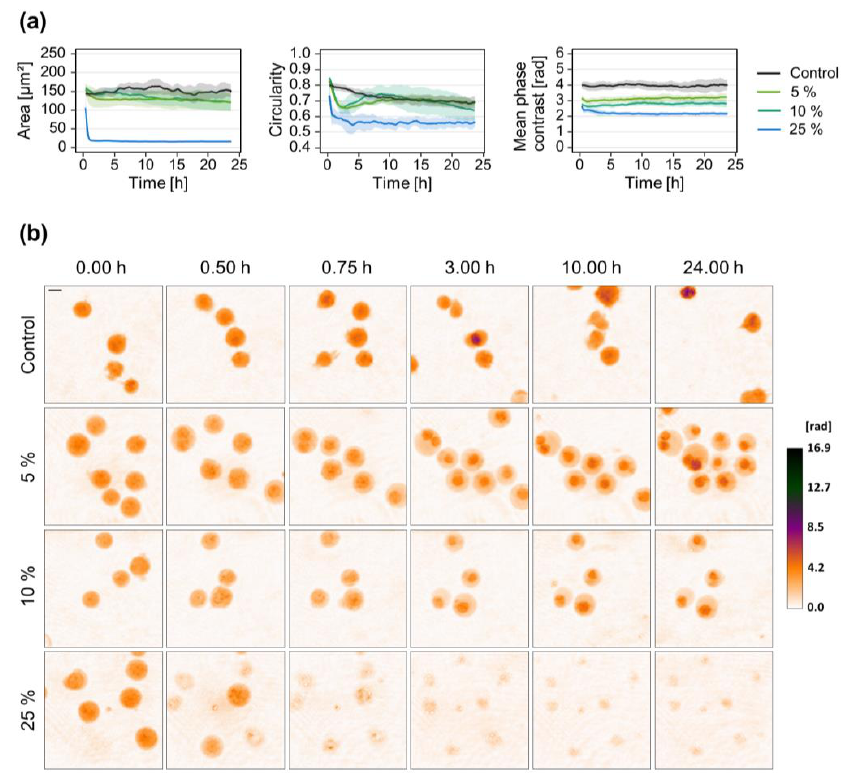
Figure 2. Concentration-dependent effect of S. aureus strain 6850 culture supernatant on Jurkat cell morphology. Jurkat cells were treated with different concentrations of sterile culture supernatant derived from S. aureus strain 6850. Untreated cells served as control. Time-lapse DHM was applied to investigate dynamic morphological changes. ( a ) DHM quantitative phase contrast images were analyzed for the average single-cell area ( µ m 2 ), average circularity (AU), and mean phase contrast (rad) per cell. Results represent mean (lines) ± SD (shading) of at least three independent experiments. Controls are shown in black while different colors indicate different concentrations of supernatant. For better visualization, curves were smoothed using moving averages with a window size of 15 measuring points. ( b ) Representative color-coded phase contrast images of Jurkat cells at indicated time points after the addition of bacterial supernatant. The scale bar corresponds to 10 µ m. The calibration bar indicates phase contrast values in